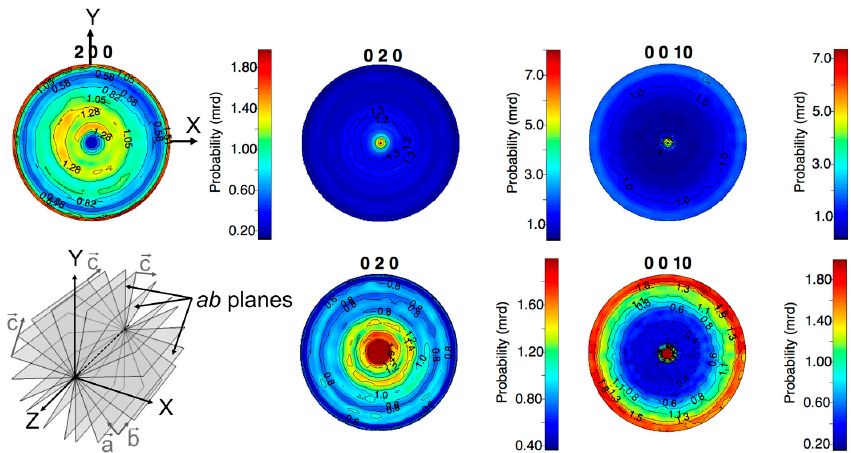
Figure 4. Bi-2212 {200}, {020}, and {0010} normalized pole figures refined from D1B data. The {020} and {0010} are also shown with a different color scale to provide more detail in the <2 multiples of a random distribution (m.r.d.) range. The main texture component is schematized in the bottom-left panel.